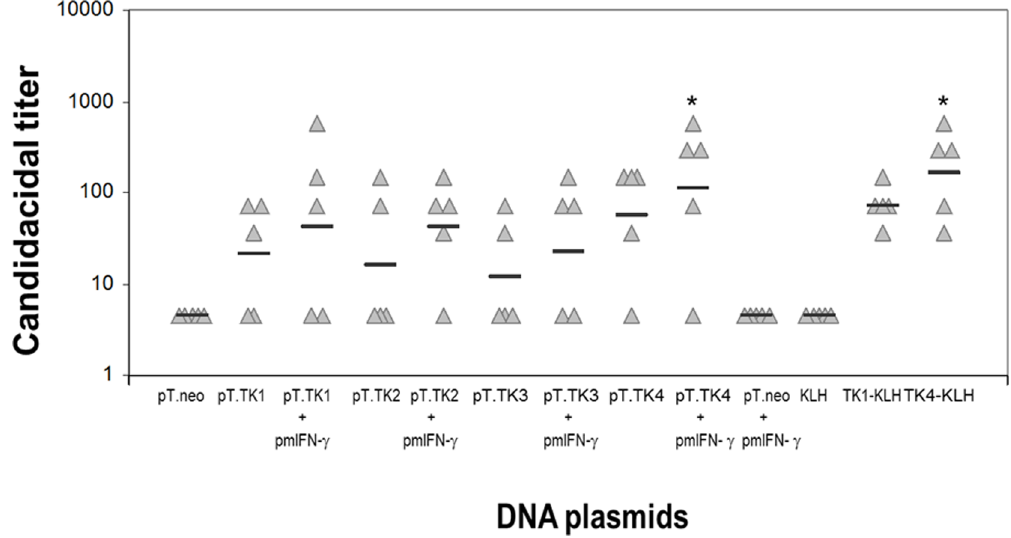
Figure 3. Candidacidal titers in immunized animals. Hundred m g of plasmids containing the selected peptide sequences (pT.TK1, pT.TK2, pT.TK3, and pT.TK4) or empty vector (pT.neo) were given three times i.m. and serum was collected at day 56 after the first immunization. To